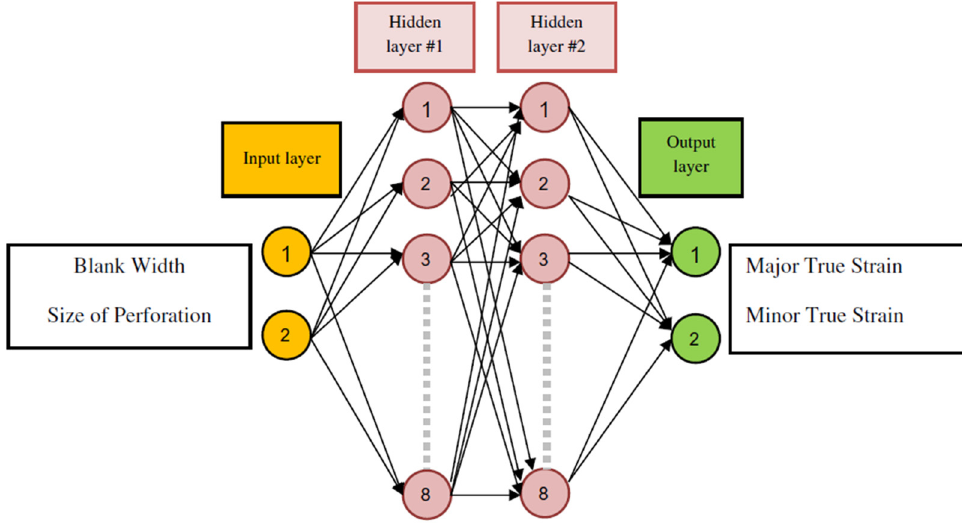
Figure 33. A schematic description of ANN-based model. Reprinted from Ref. [412] with permission. Copyright 2010, Elsevier.